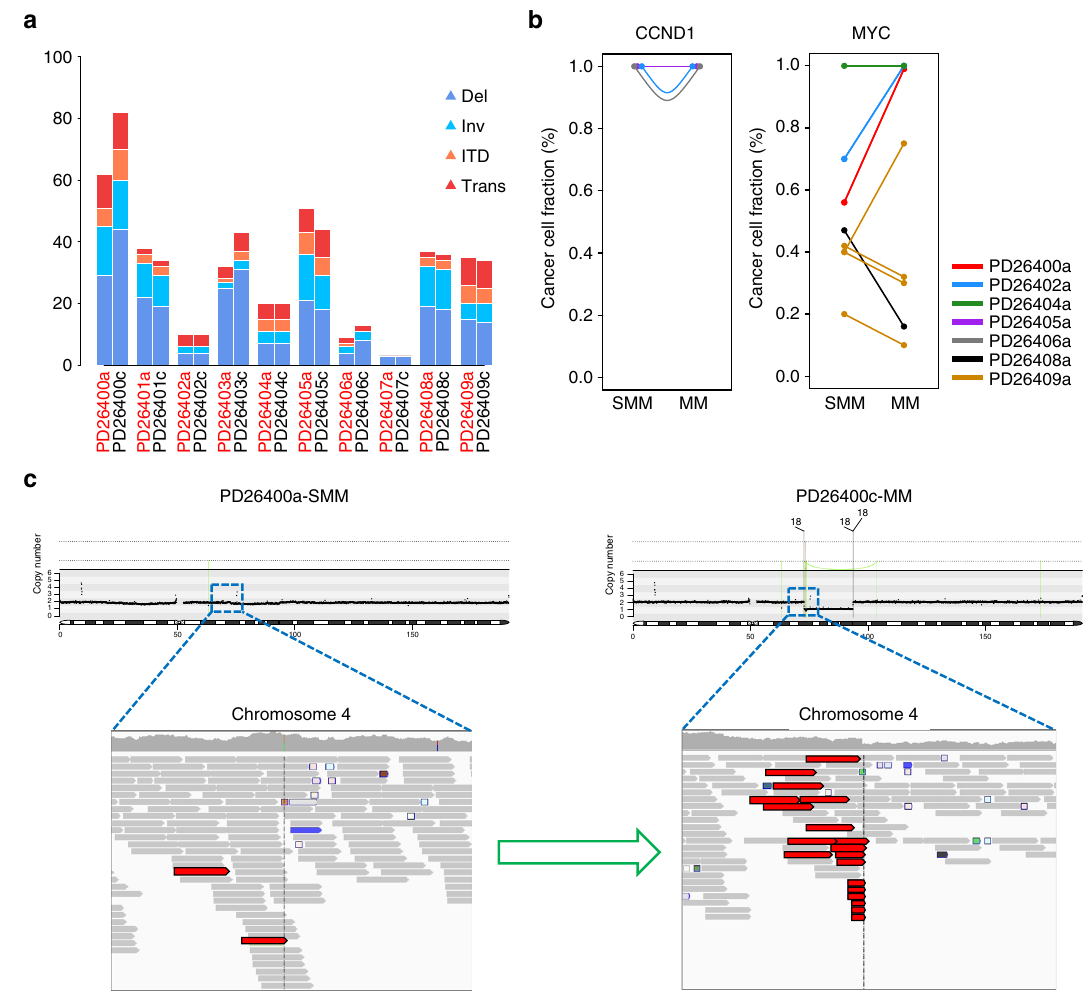
Fig. 3 Rearrangements prevalence and involvement in smoldering MM progression. a Bar plot representing the rearrangement prevalence in all smoldering ( x -label in red) and symptomatic MM patients ( x -label in black), broken down by rearrangement type. b IGH (left) and MYC (right) translocated cases are plotted by allelic fraction changes during progression. Each line is color-coded for each patient. Notably patient PD26409 (yellow) had four independent MYC rearrangements, but only one increased its clonality upon progression to MM. c An example of progression associated with evolution of the clonal fraction of a translocation with unknown driver